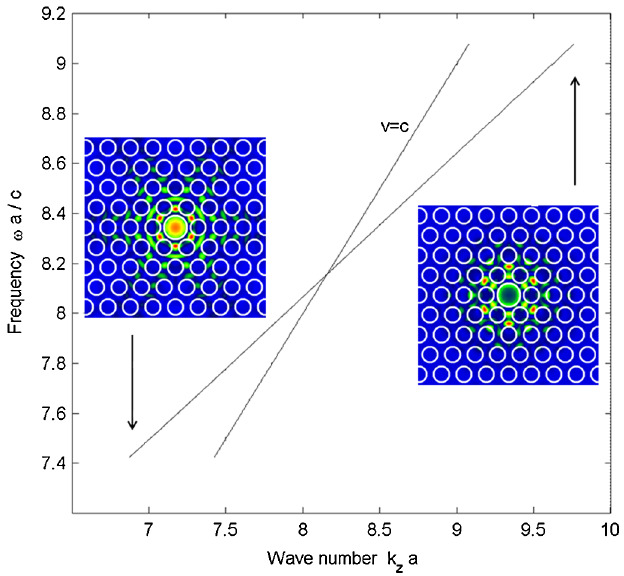
FIG. 4. The TM mode dispersion curve near the light line ( v ¼ c ) as calculated with the multipole method. Insets show E field for modes at long wavelength ( k z 1 : 08 c , and short wavelengths ( k